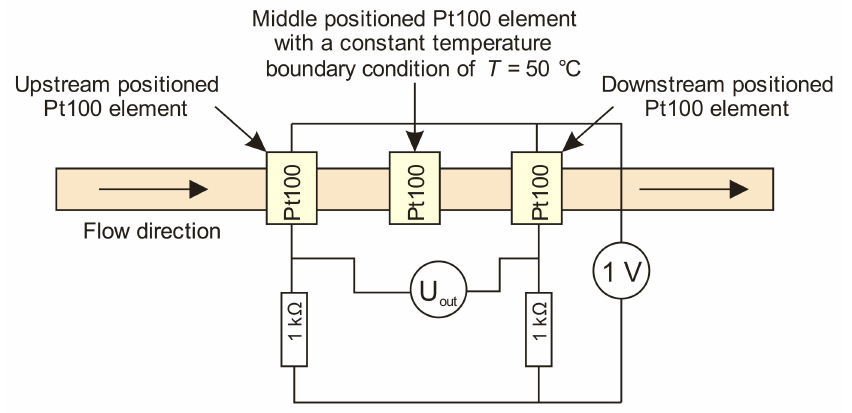
Figure 5. A wiring diagram of a constant temperature thermal mass flowmeter in S-H-S configuration which was implemented in a Comsol simulation model.